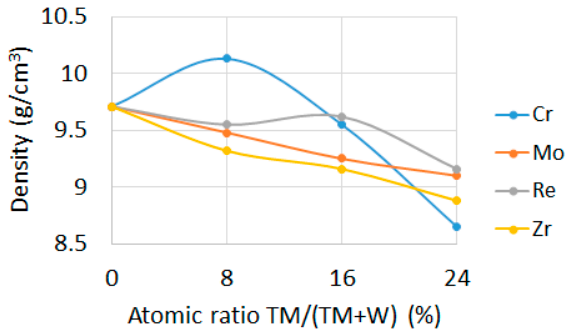
Figure 2. Changes in the density of the SPSed samples in function of amount and type of admixture TM (where TM = Cr, Mo, Re,